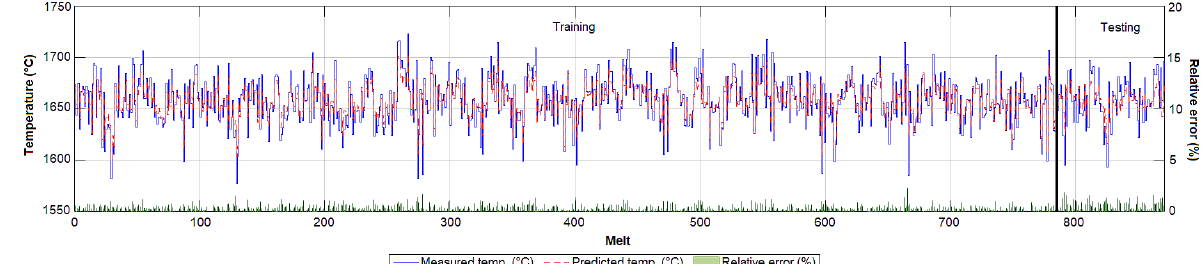
Figure 11. Prediction of endpoint melt temperature by RF model.